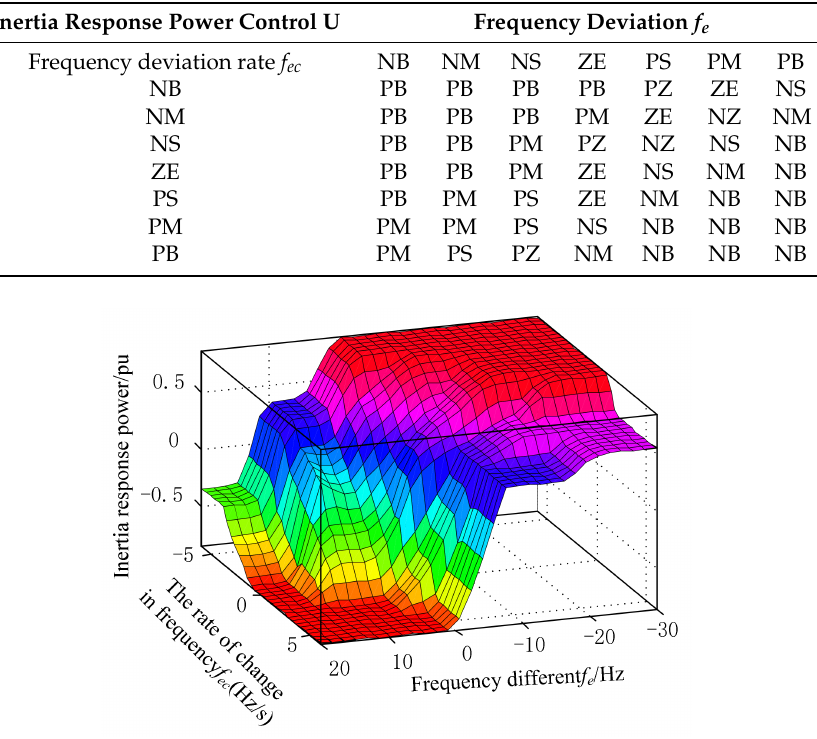
Table A3. Fuzzy logic rules for controller.